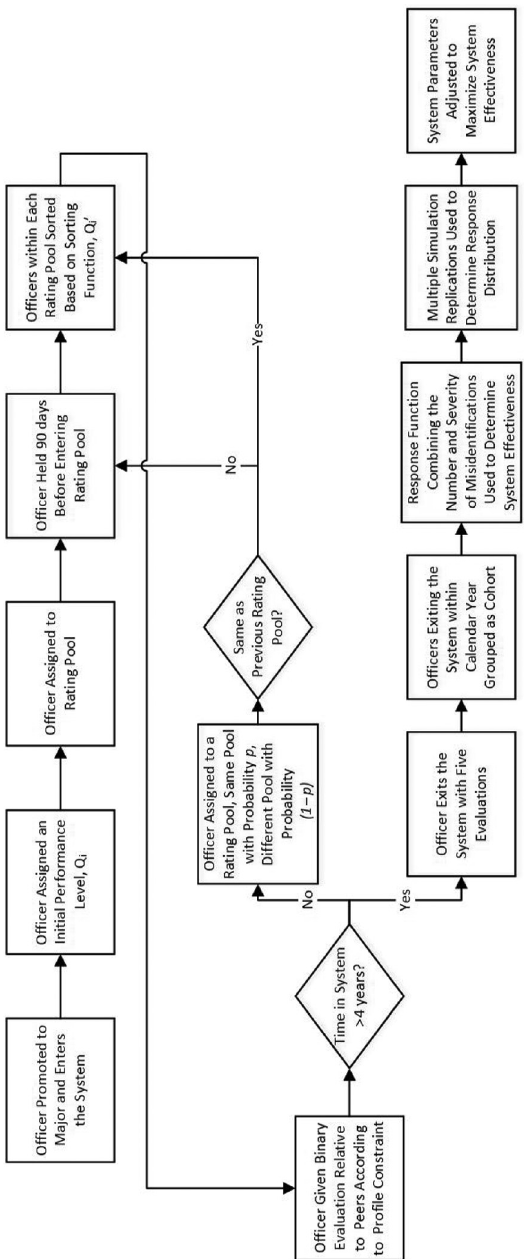
Figure 2. Flow chart of the of fi cer evaluation system